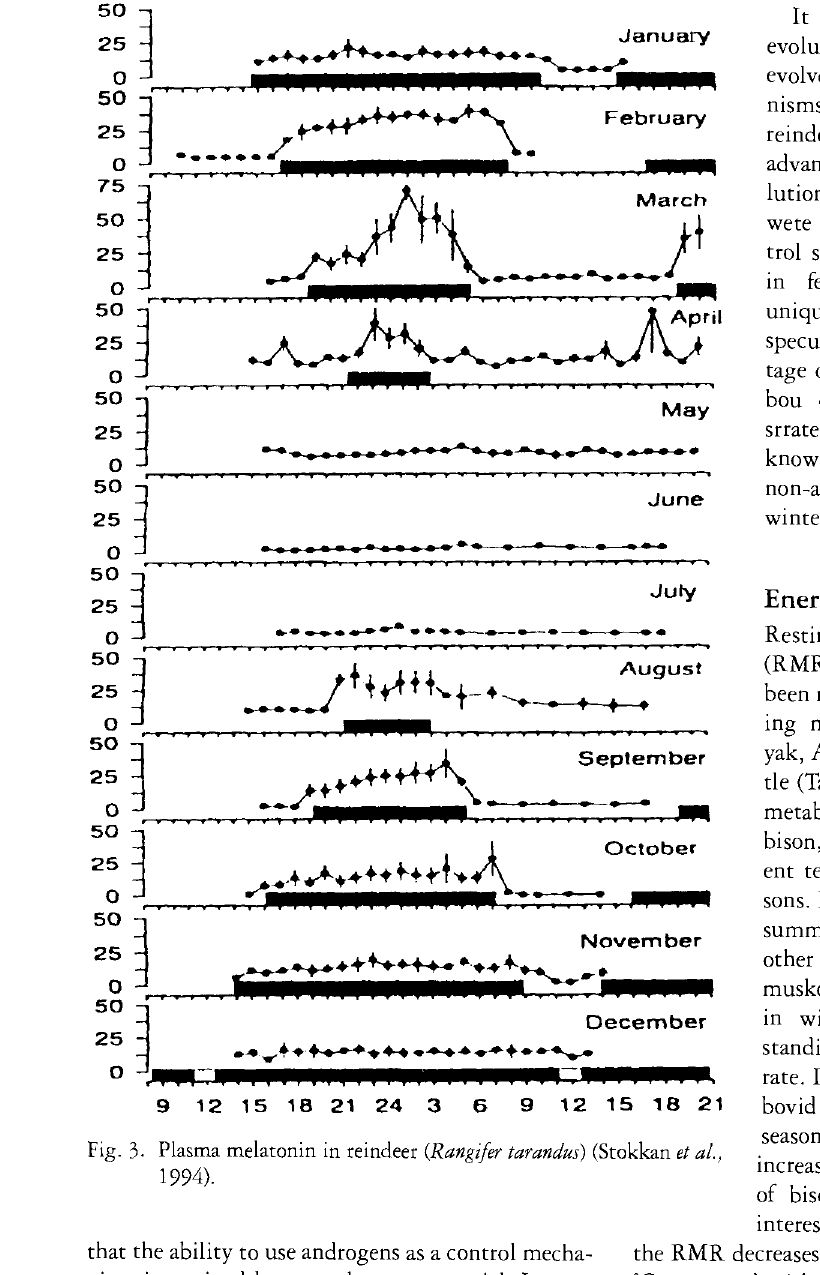
Fig. 3. Plasma melatonin in reindeer (Rangifer tarandus) (Stokkan et al.,